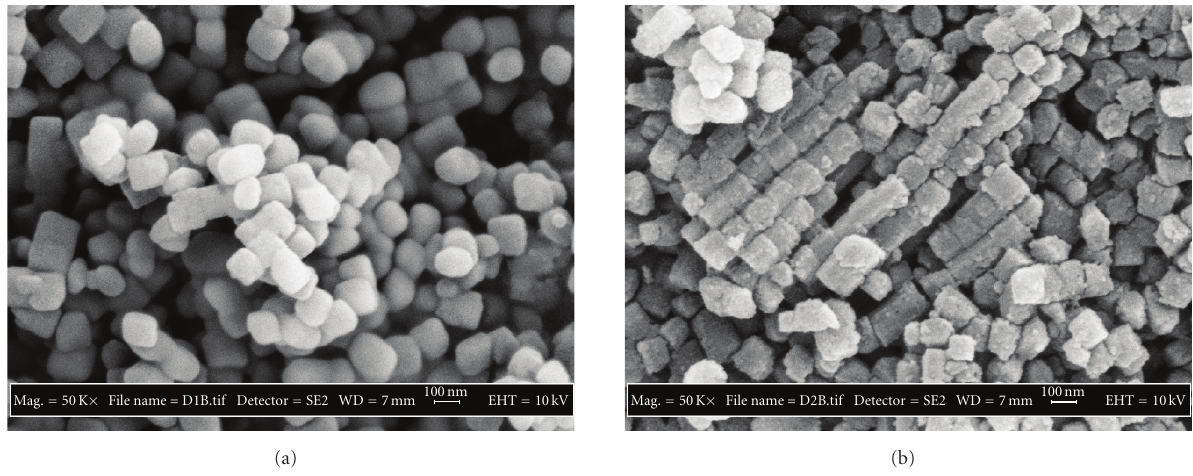
Figure 9: The FESEM images of the materials (a) TS-1 and (b)